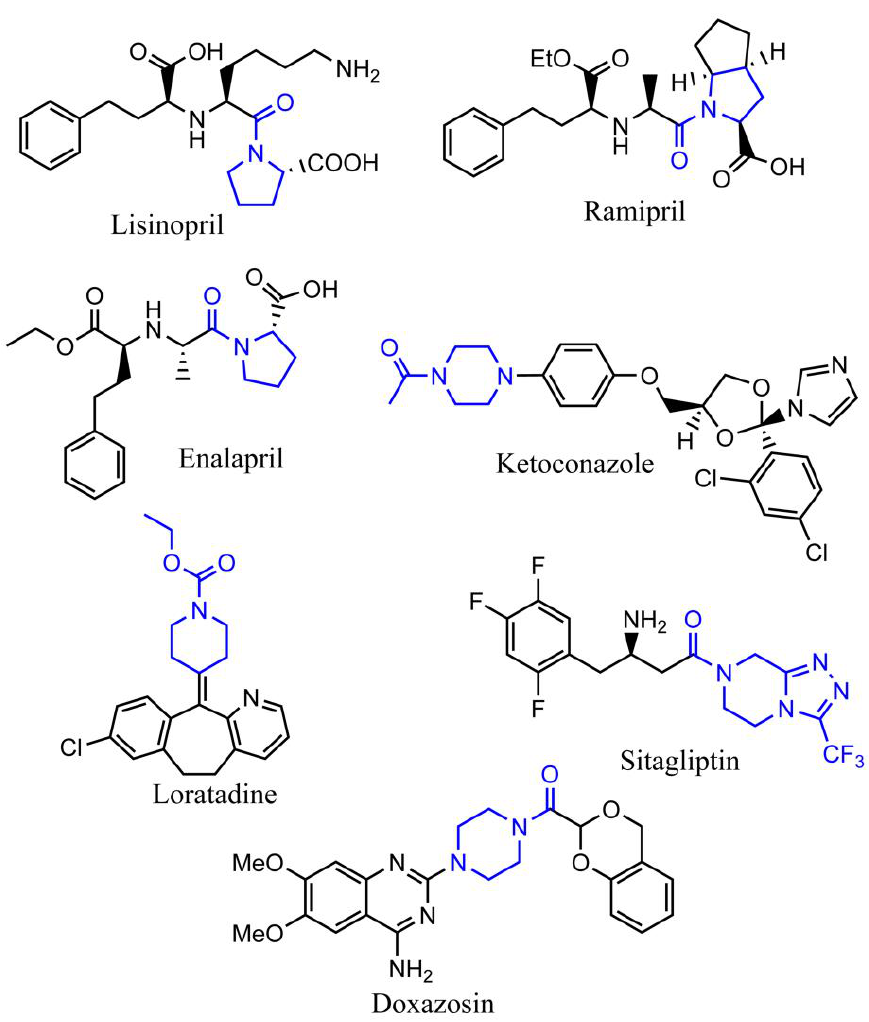
Figure 1. The representative marketing drugs that have amide ligation on the nitrogen-containing heterocycle structure. The blue color indicates the featured structure of each molecule.